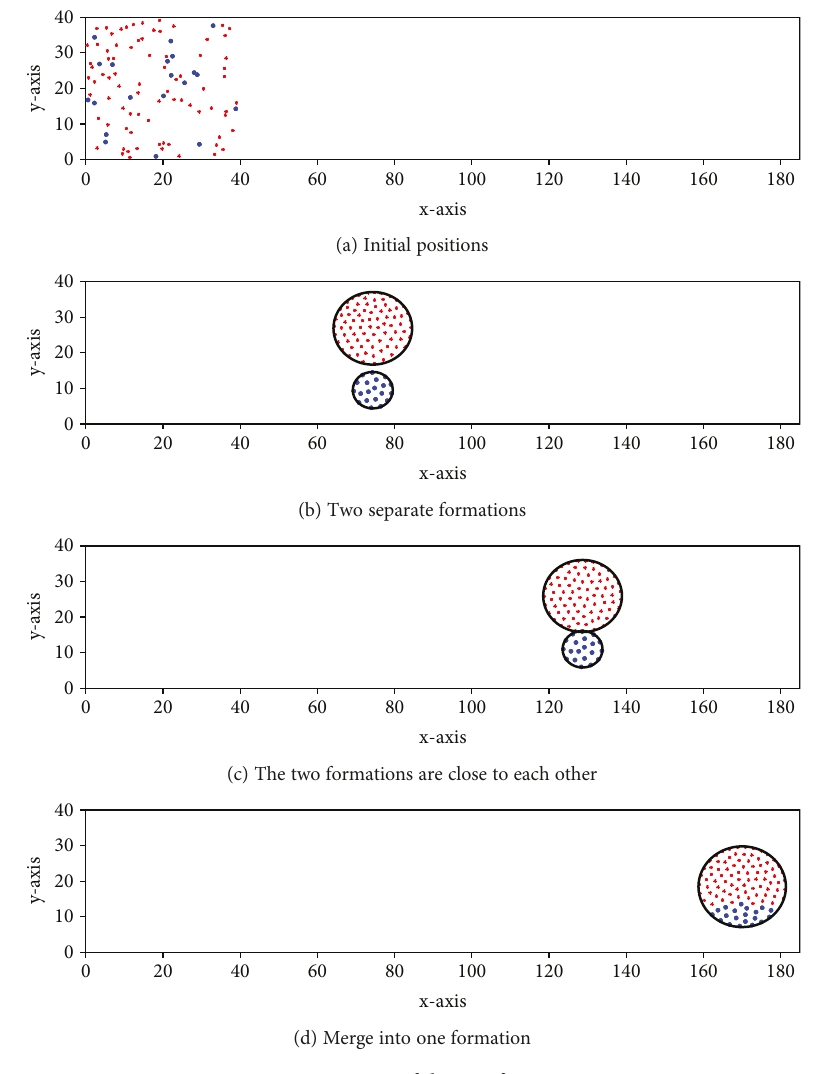
Figure 3: Merging of the two